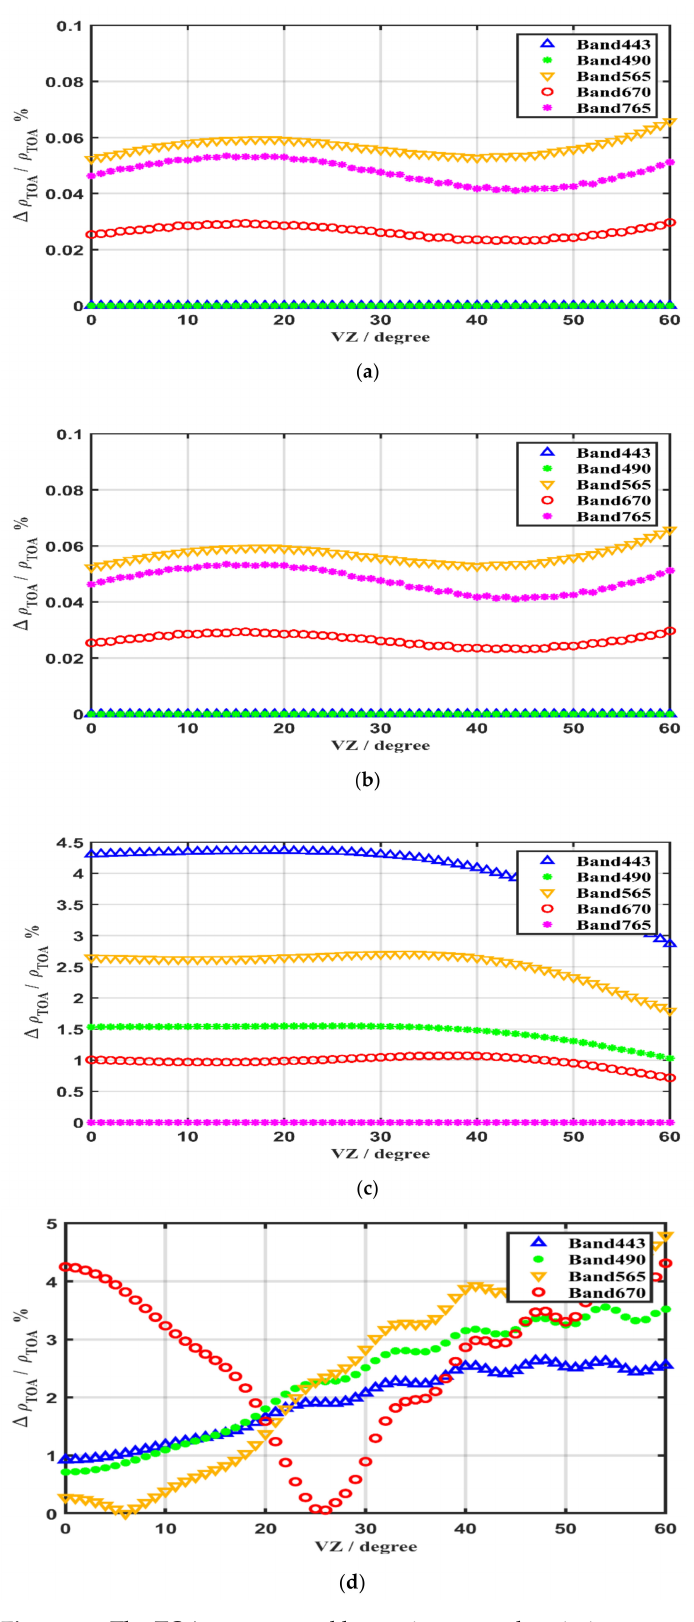
Figure 10. The TOA error caused by environmental variation over an SNES: ( a ) The error caused by water content uncertainty. ( b ) The error caused by ozone uncertainty. ( c ) The error caused by chlorophyll II concentration uncertainty. ( d ) The error caused by different aerosol